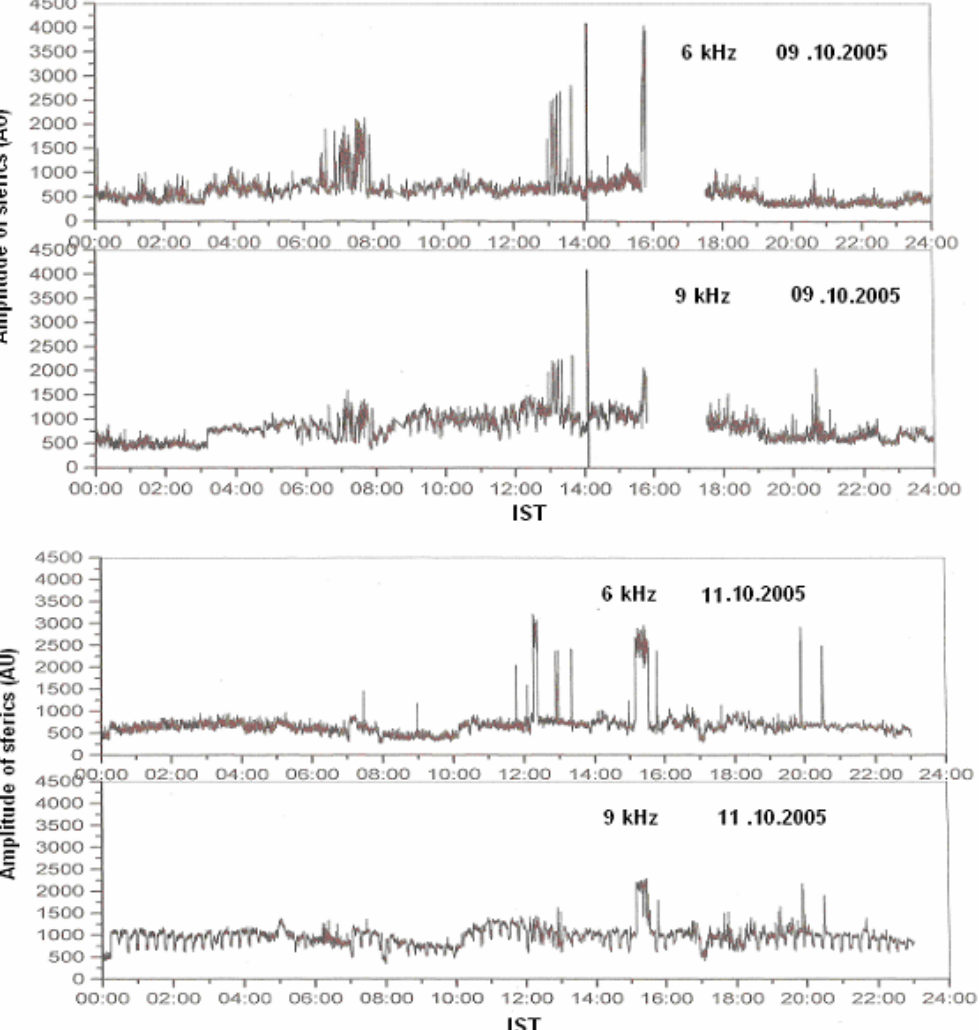
Fig. 11. Diurnal variation of sferics with spikes observed over Agartala on 9 October (upper two records) and 11 October 2005 (lower two